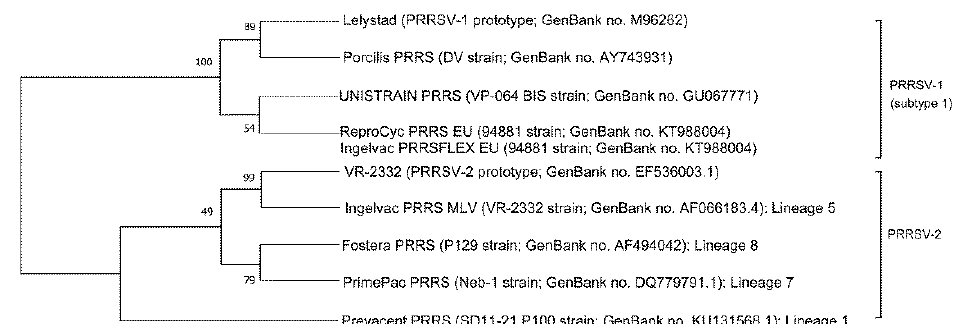
Figure 1. Phylogenetic analysis. Open reading frame 5 genome from the vaccine viruses with prototype of Porcine Reproductive and Respiratory Syndrome Virus (PRRSV)-1 (Lelystad) and PRRSV-2 (VR-2332). An unrooted neighbor-joining tree was constructed from aligned nucleotide sequences.